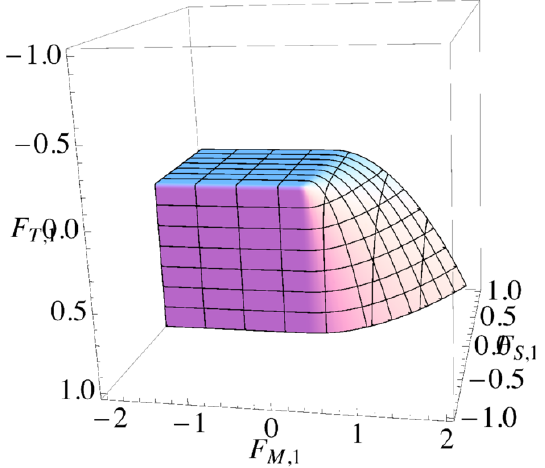
Figure 14 . Positivity bound from the quadratic inequality in the WW channel, in the subspace spanned by F S; 1 , F M; 1 and F T; 1